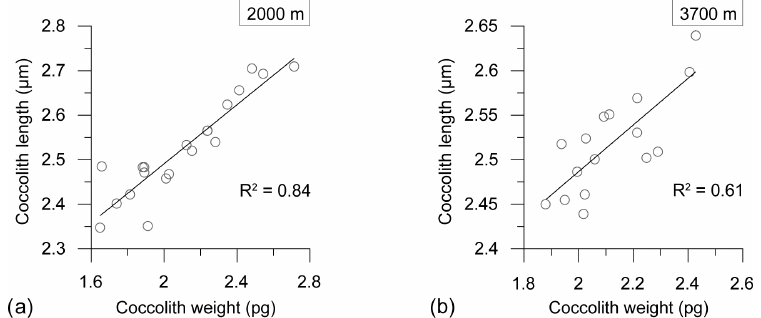
Figure 7. Regression plots between E. huxleyi coccolith mass (pg) and length (µm) at the 2000m (a) and 3700m (b) sediment